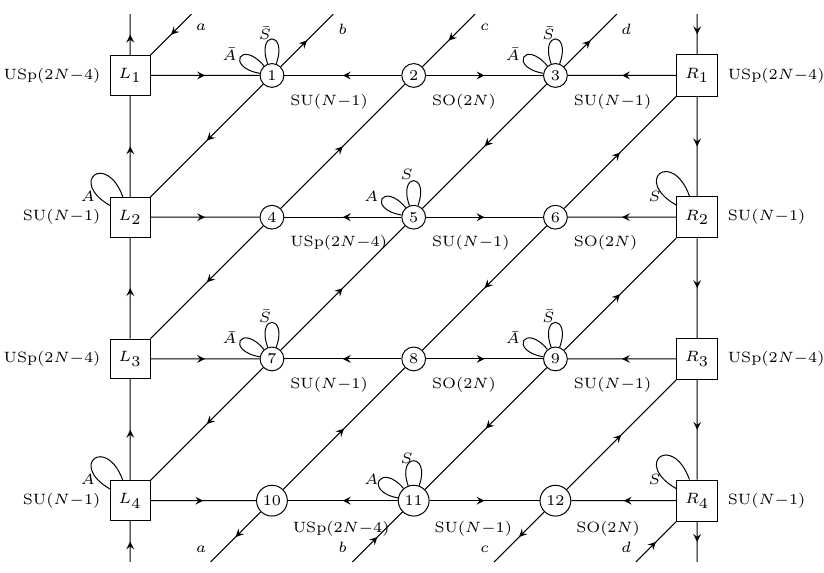
Figure 3 . A quiver theory on a two-punctures sphere, for k = 2. The theory is constructed from the domain walls (4.2), (4.6), and (4.8), but it is not glued to a torus. As for the torus theory of (cid:12)gure 2, the diagonal lines are identi(cid:12)ed according to the labels a , b , c , d .